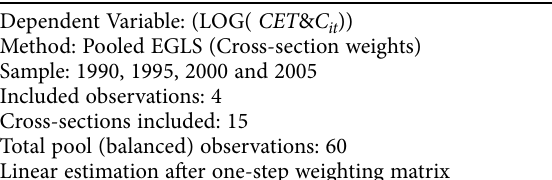
Table 6. Estimation equation for employee compensation across autonomous regions